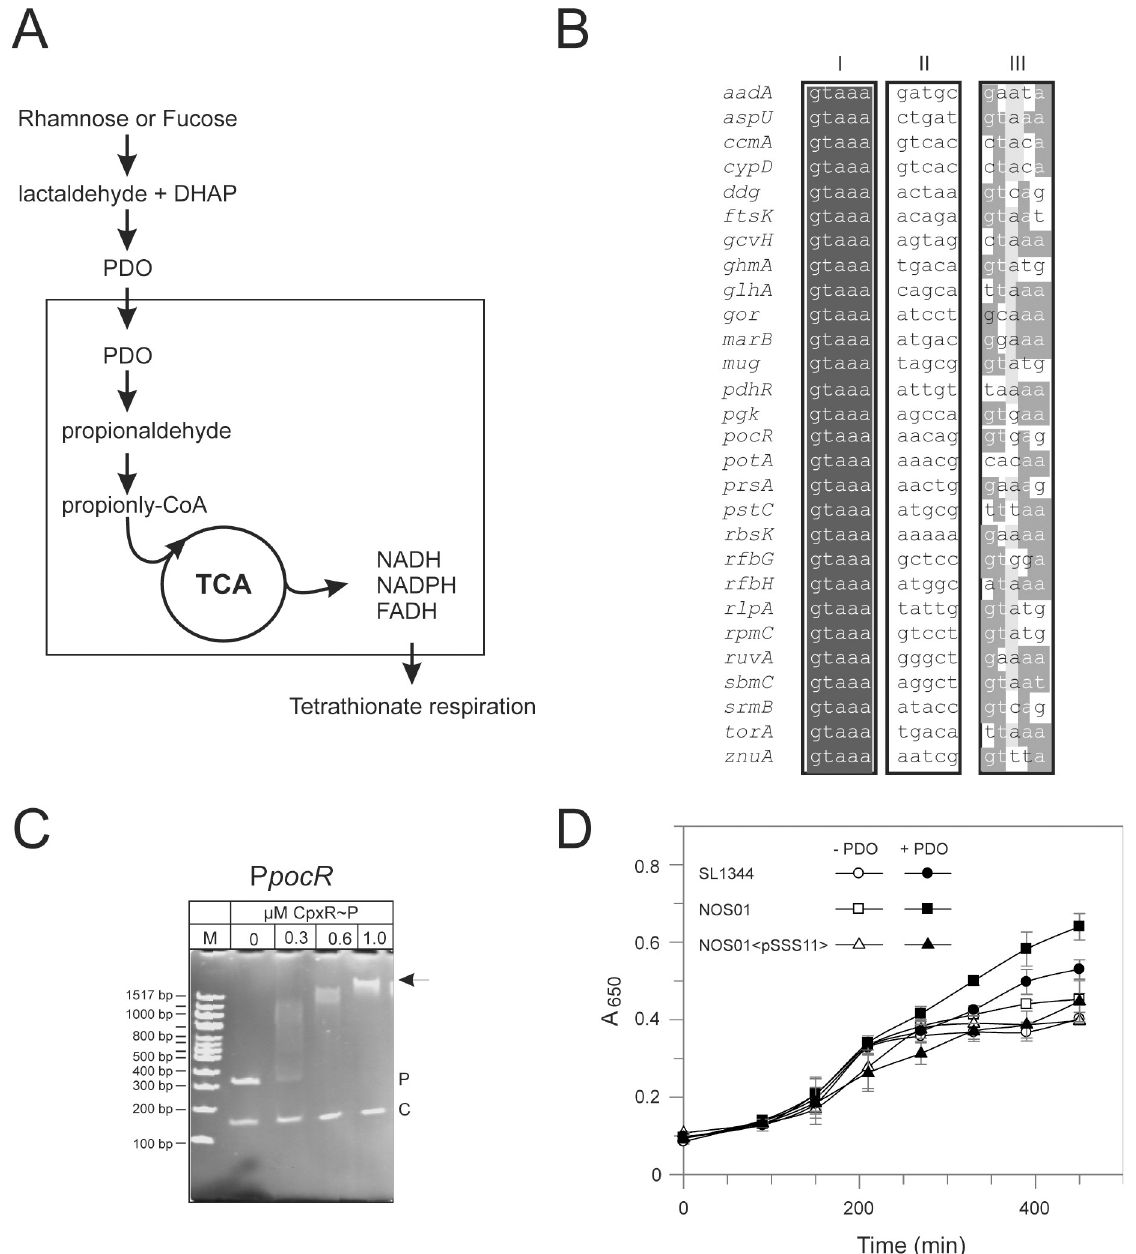
Fig 8. Cpx envelope stress system enhances 1,2-propanediol-dependent anaerobic growth of S . Typhimurium. A. The diagram outlines the principle steps in the metabolism of 1,2-propanediol (PDO). B. Potential novel Cpx regulon members of S . Typhimurium identified by bioinformatics based screening. The left (I) and right [28] pentamers and the 5-bp spacer [28] are displayed as a heat-map to show bases of high conservation (dark grey) from degenerate regions (light grey/white) (compare Fig 2). The genes controlled by these promoters are indicated to the left of the sequences. C. EMSA analysis verifies CpxR binding to the pocR promoter. PocR promoter fragment (p) was incubated without or with increasing amounts of the purified and phosphorylated CpxR protein. The DNA-CpxR~P complexes were separated on 4% polyacrylamide gels. The corresponding molecular weights are indicated on the left. The positions of the promoter fragments are indicated (p), arrows show the higher molecular weight DNA-CpxR~P complexes. A fragment of the cpxP promoter region without the CpxR~P binding motif (-151 to -297) was used as negative control (c). D. Stimulation of anaerobic growth by 1,2-propanediol (PDO) was determined according to an established protocol [24]. Cells of wild-type S . Typhimurium strain SL1344, the cpxR mutant NOS01, and the cpxRA overexpressing strain NOS01 < pSSS11 > were grown anaerobically on minimal NCE medium supplemented with 0.2% yeast extract as carbon source with or without 80 mM PDO as energy source. Shown are the means ± S.E.M. of biological quadruples